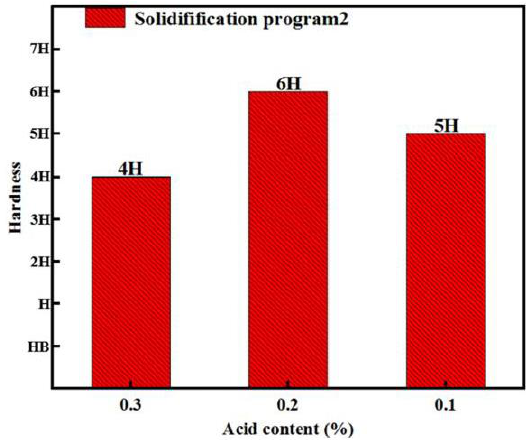
Figure 3. Hardness comparison of different acid content coatings.